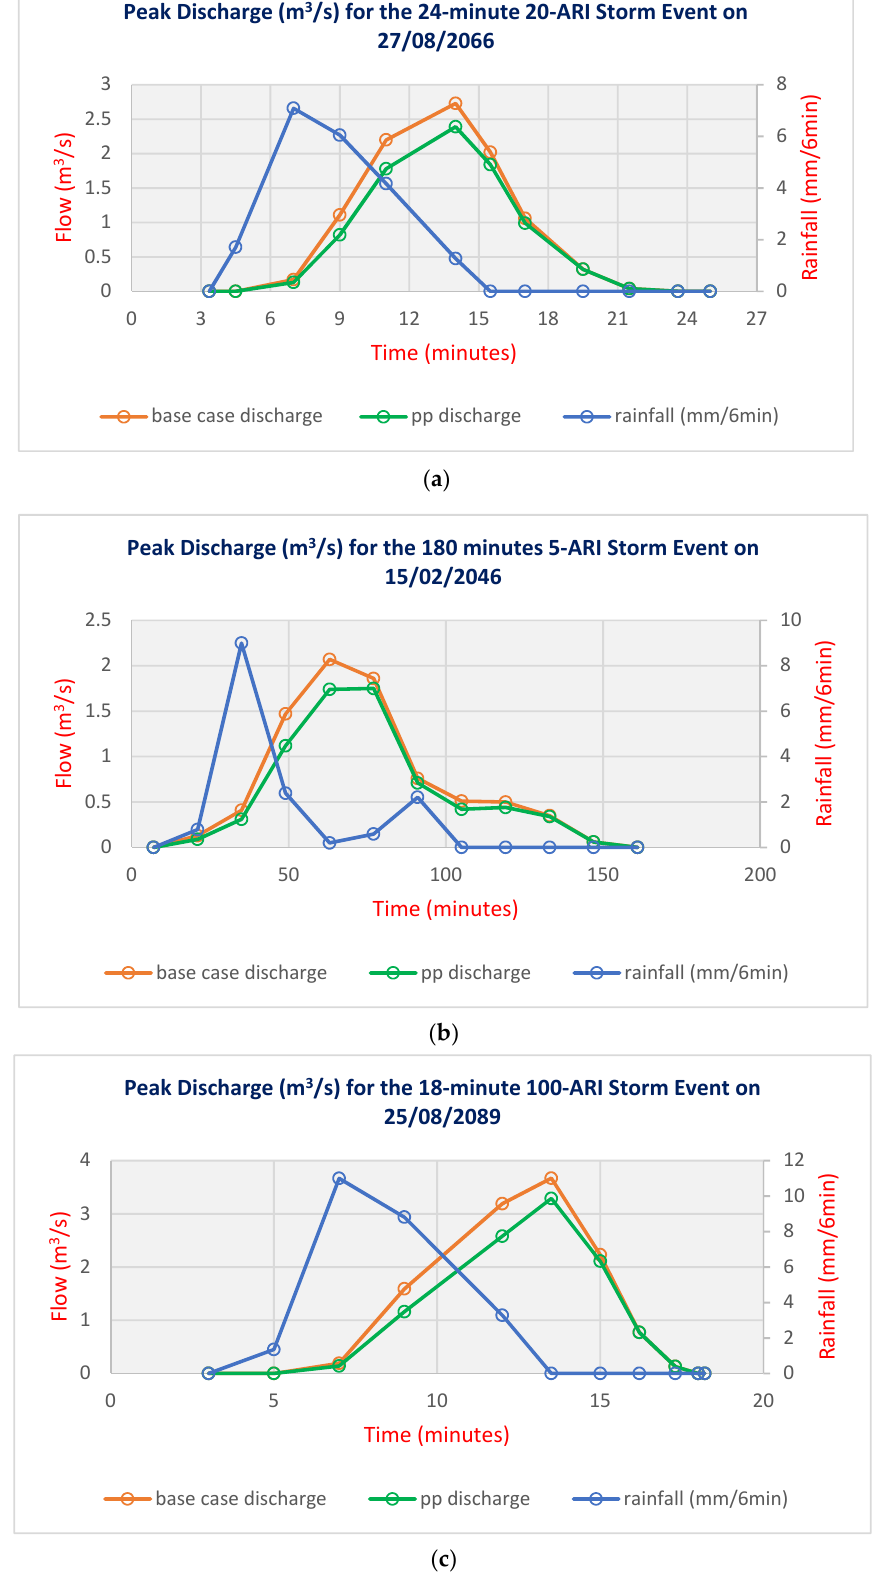
Figure 6. Peak flow delay for different storm events: ( a ) 5 year ARI, ( b ) 20 year ARI, and ( c ) 100 year ARI. The rainfall in mm/6 min has also been plotted to illustrate the lag between peak rainfall and peak runoff. The dates of the storm events are when they occur in the synthetic time-series. These results show that the permeable pavement can infiltrate surface runoff and delay peak flow and amount. However, clogging and the duration of the rainfall events will determine the infiltration capacity of permeable pavements [18].